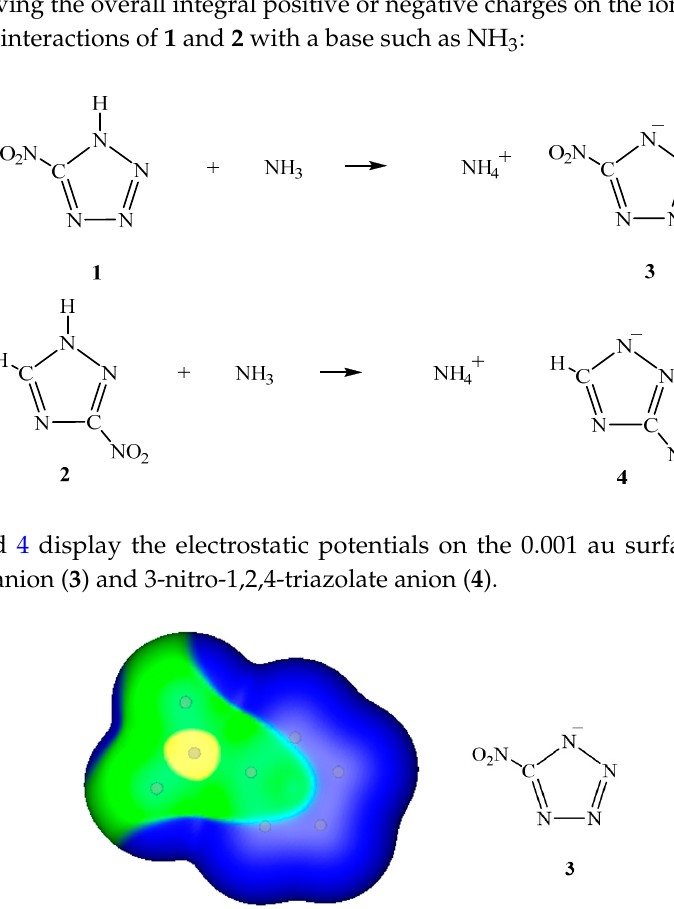
Figure 3. Computed electrostatic potential on 0.001 au anionic surface of 5-nitrotetrazolate anion ( 3 ). Color ranges, in kcal/mol, are: yellow, between − 60 and − 80; green, between − 80 and − 100; blue, more negative than − 100. Circles show positions of atoms; NO 2 group is on the left. Most negative potentials are − 126 kcal/mol by the ring nitrogens closest to the carbon bearing the NO 2 group.